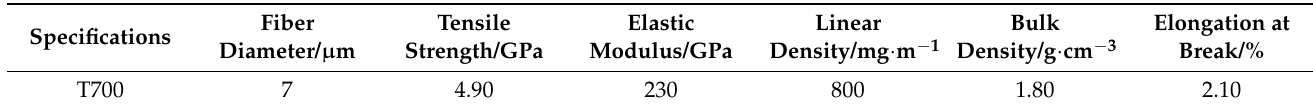
Table 1. Specifications and properties of carbon fibers.